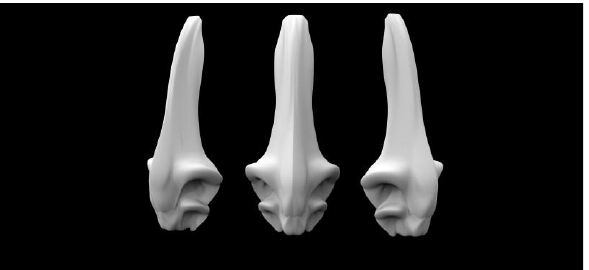
Figure 3 | Nose project Double nostrils – rendered nose in different views.